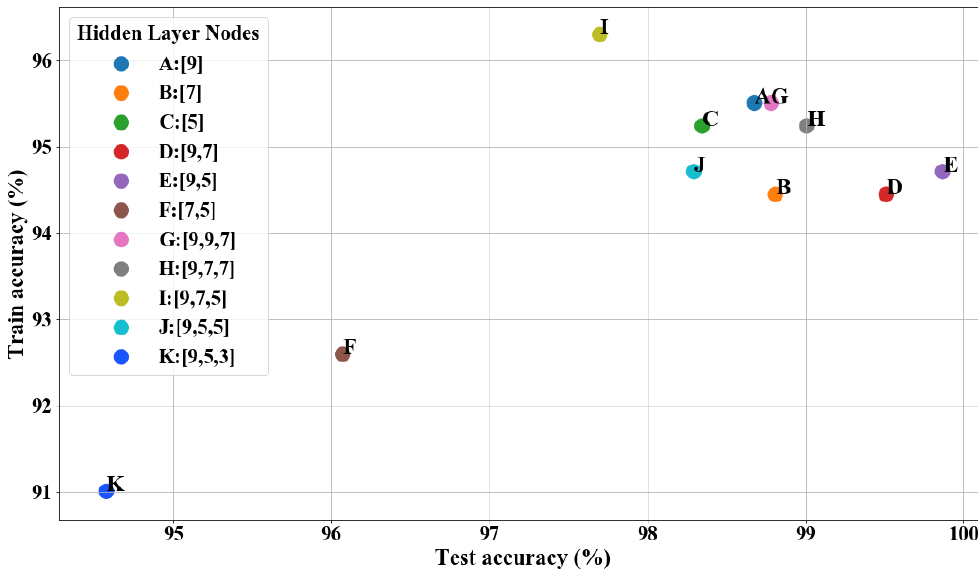
Figure 12. Performances of neural network models with different